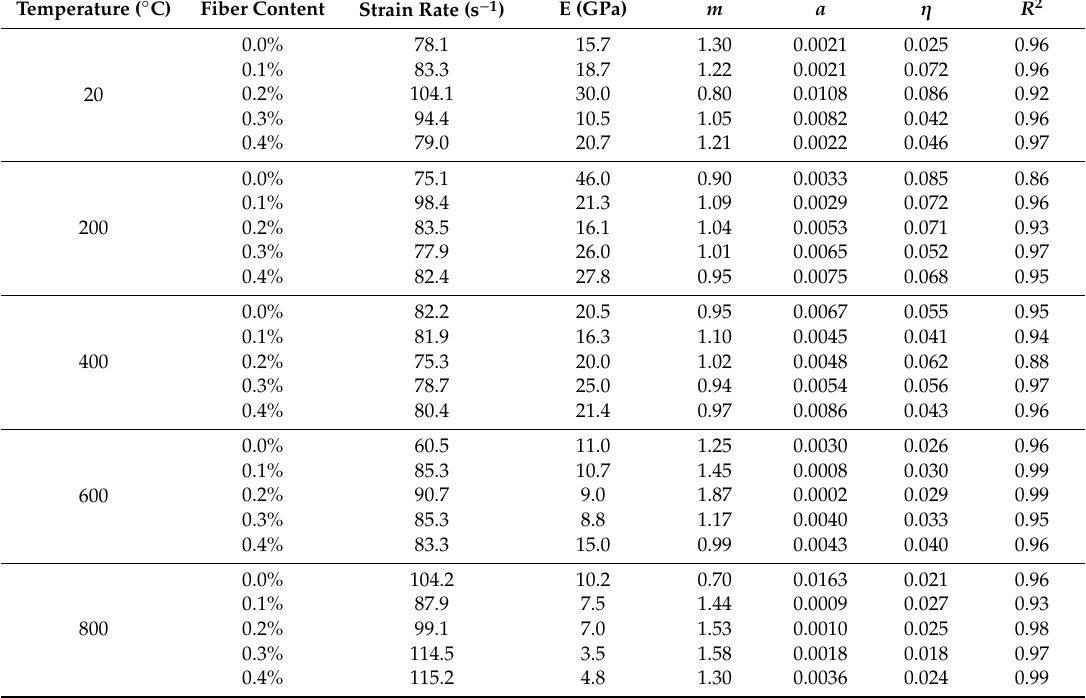
Table 4. Inversion results of model parameters under di ff erent